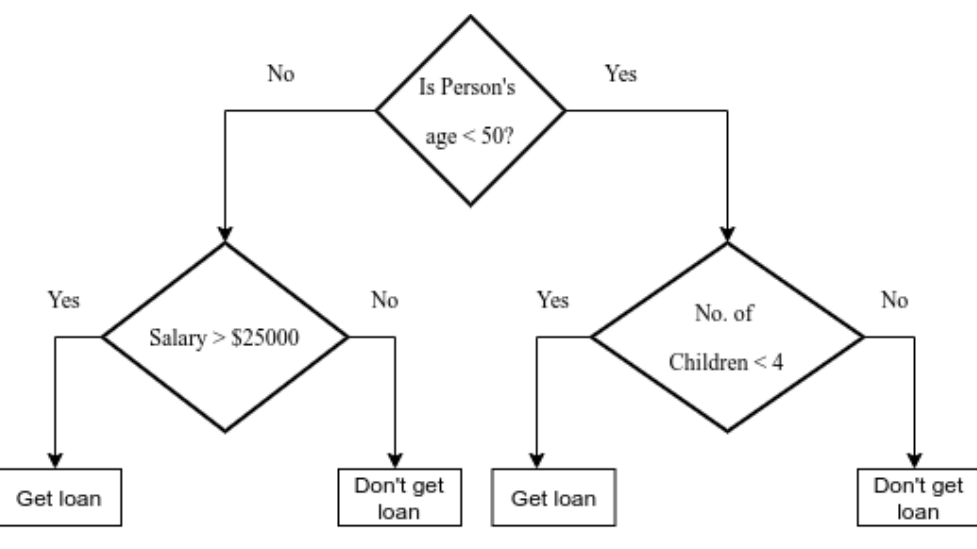
Figure 2. An example of a DT.